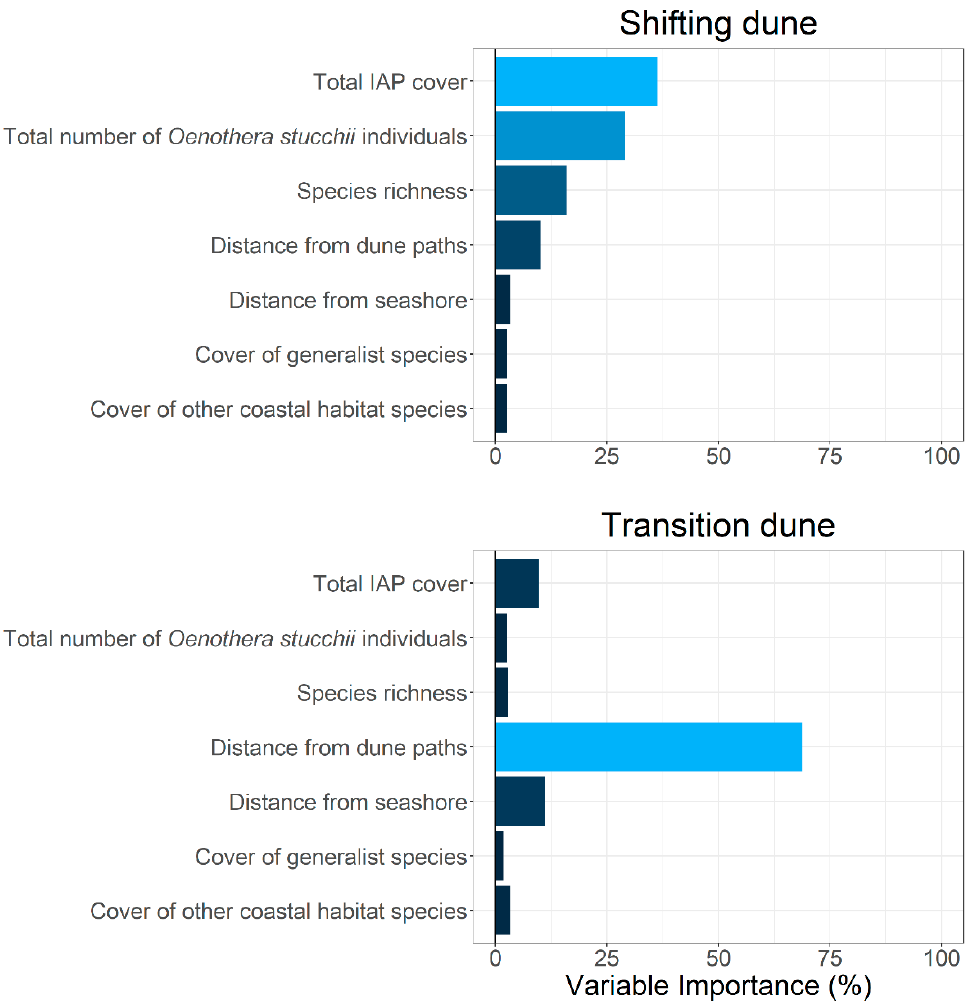
Figure 2. Community composition and environmental covariates for shifting and transition dunes using cover of diagnostic species as response variable. Mean square error (MSE) was used to assess variable importance, reported as percentage. Light blue bars indicate the most important variables.